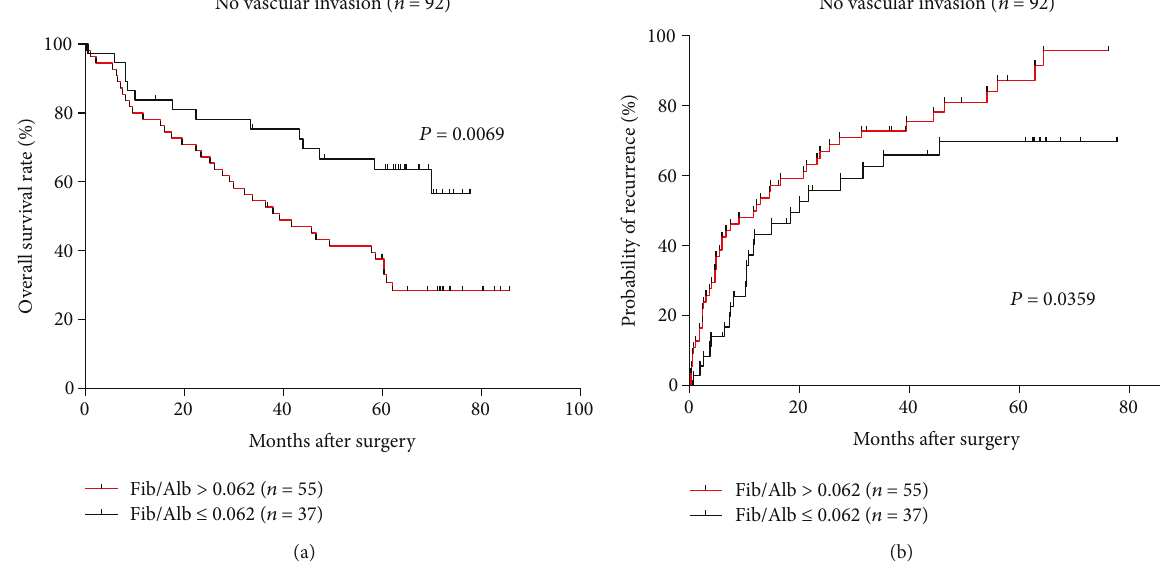
Figure 4: Kaplan – Meier survival curves of HCC patients without microvascular invasion. Fib/Alb ratio > 0.062 was signi fi cantly correlated with a shorter OS (a) and higher recurrence rate